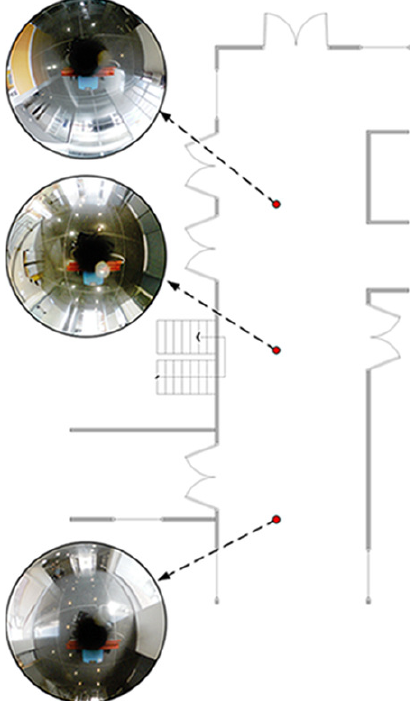
Figure 18. Mockup for Dataset 2. Three views of the environment are